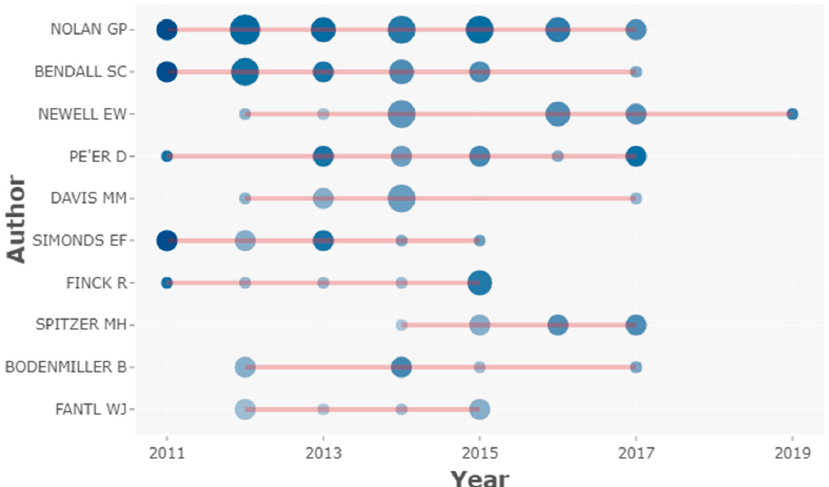
Figure 3. Top authors’ production over time. The horizontal red lines indicate the scientific production timeline per author from 2010 to 2019. The circle size represents the number of HCPs published per year and the colour intensity (colour coding) is proportional to the sum of total citations per year. The figure was created using Biblioshiny web interface.